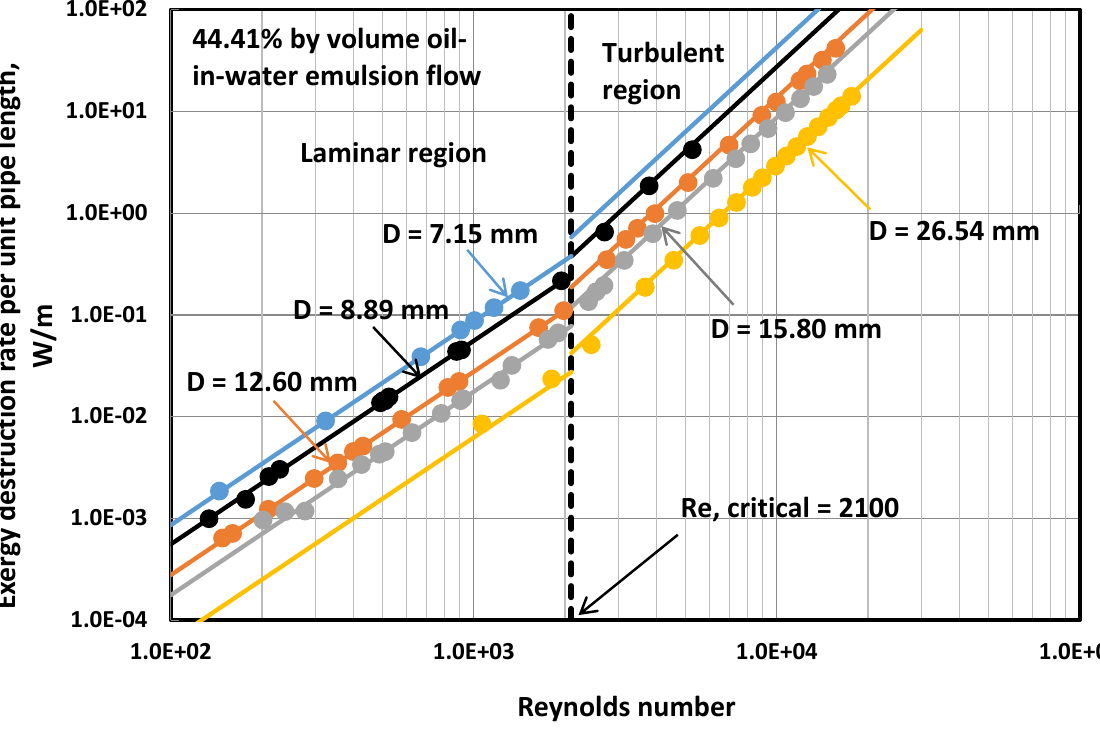
  versus Re plots for 44.41% by vol. O/W emulsion flow in different diameter pipes. Figure 10. D